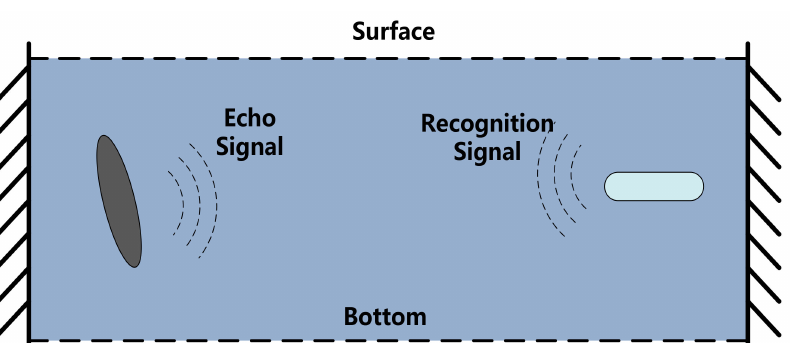
Figure 9. Experimental platform.